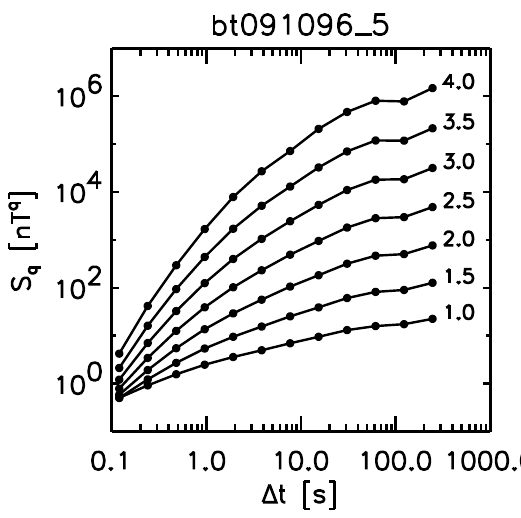
Fig. 5. The structure function of the magnetic field shown in Fig. 2. Curves are labeled with the power q